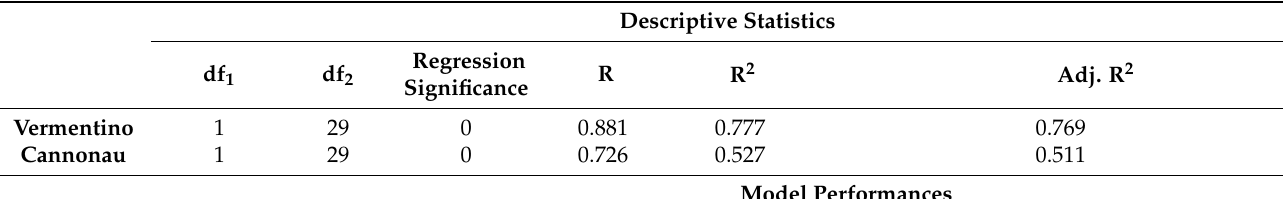
Table 3. Validation of the linear regression model (m Ψ s = α + ß × I IN ) between midday stem water potential (m Ψ s) and the irrigation need index (I IN ) in